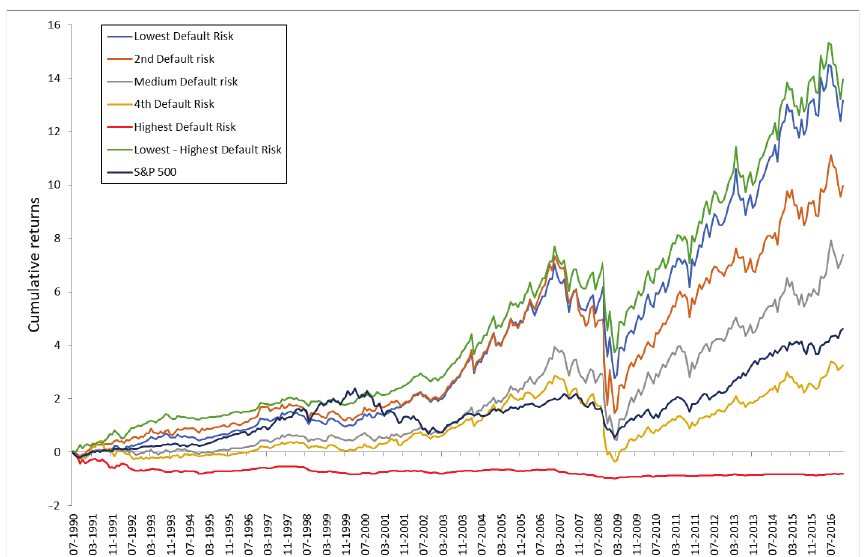
Figure 1. Cumulative returns of the default risk sorted